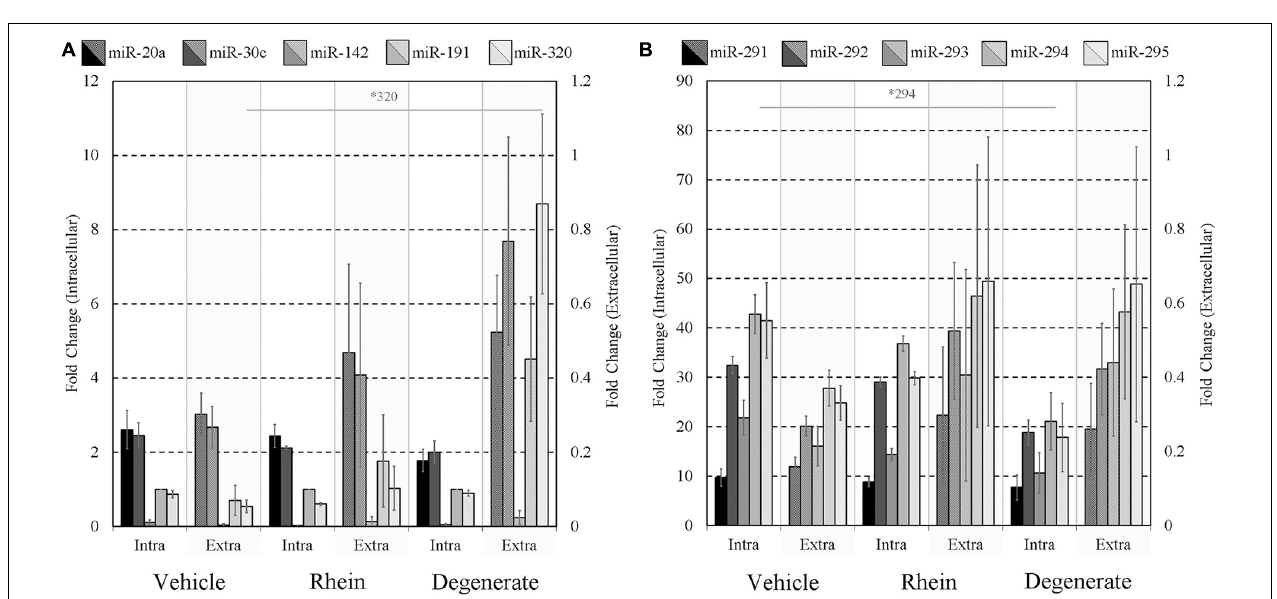
FIGURE 7 | Intracellular and extracellular miRNA profile comparison of vehicle control, rhein-treated, and degenerate embryos. Panels (A,B) intracellular and extracellular expression profiles of each embryo group are compared to identify selective or inhibited release of specific panel miRNAs. Each dataset has been normalized against endogenous intracellular miR-191. Blank media was cultured in tandem and used as a negative control. n = 3. Error bars = SEM. ∗ p < 0.05; only significant differences are labeled.